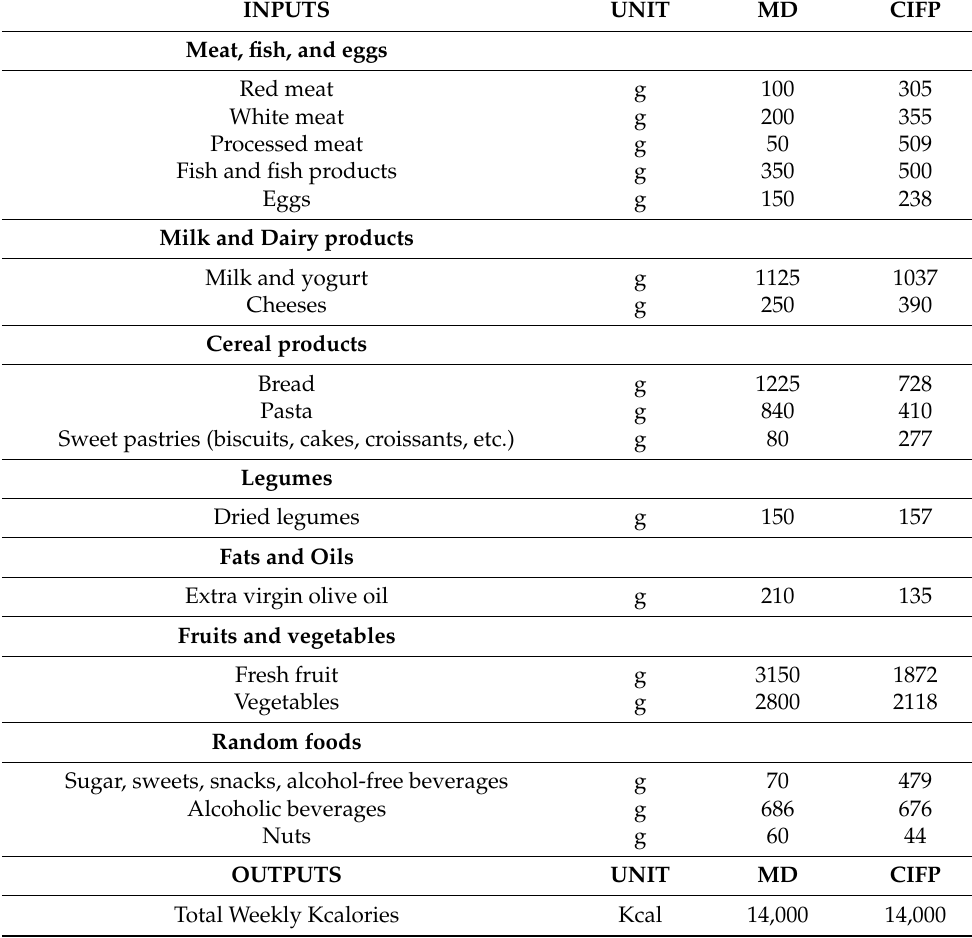
Table 1. Life cycle inventory of Mediterranean diet (MD) and current Italian food patterns (CIFP) in